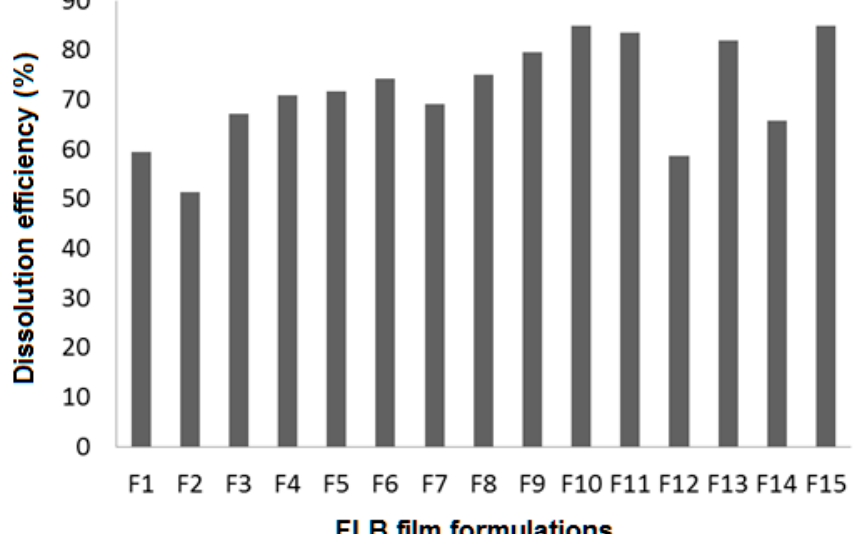
Figure 12. DE (%) for FLBFDOFs formulations.